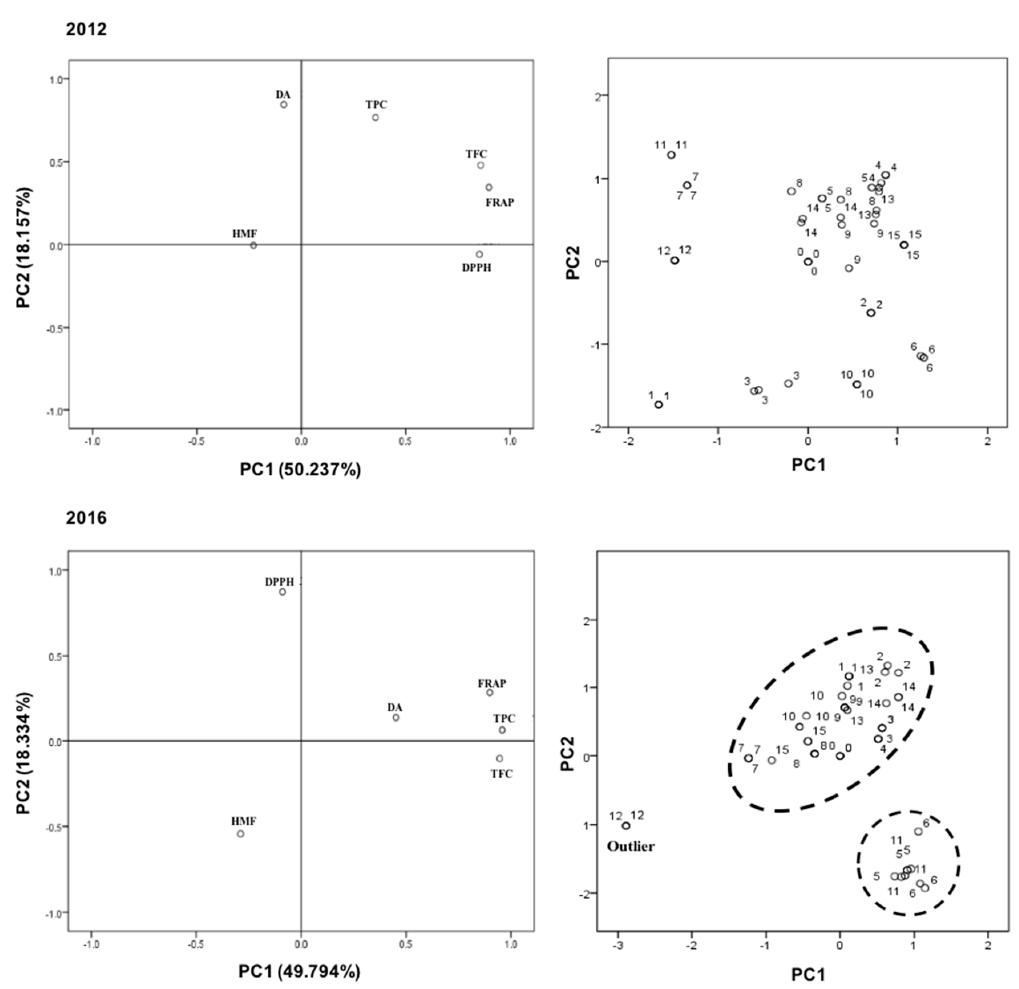
Figure 1. Principal Component Analysis (PCA) - Biplot of scores and loadings of data obtained from HMF, DA, and antioxidant parameters (TPC, TFC, DPPH • SA, FRAP) of the honey samples analysed in 2012 and 2016 ( left : PCA distribution of variables; right : PCA distribution of honey samples).